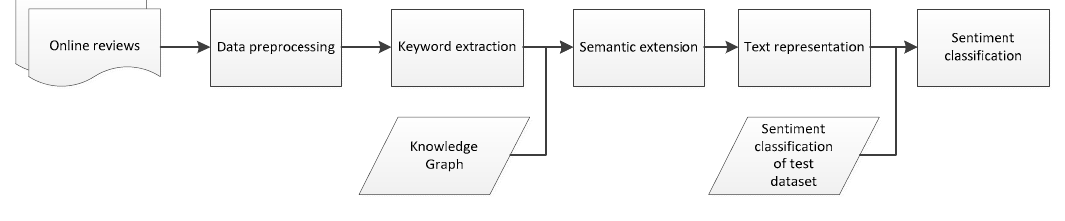
Figure 1. System framework.